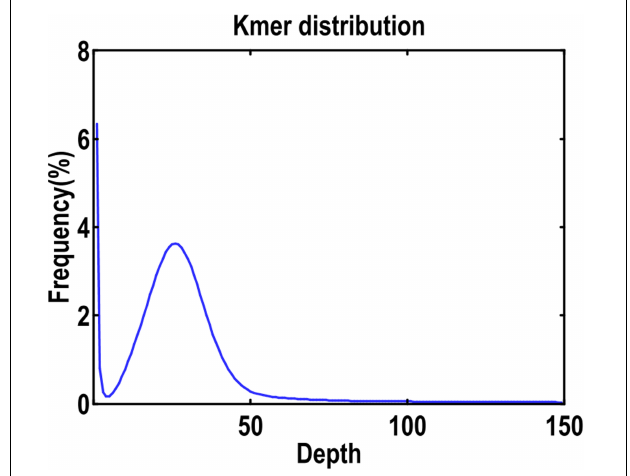
FIGURE 2 | K-mer ( K = 19) distribution of Illumina genome sequencing reads of C. buqueti . The total count of k-mers was 44976583431, and the peak k-mer depth was 64. The genome size of C. buqueti was calculated by dividing the total k-mer count by the peak depth, which was 600.92 Mb. The single peak of the k-mer distribution profile indicates that the C. buqueti genome has a low level of heterozygosity.